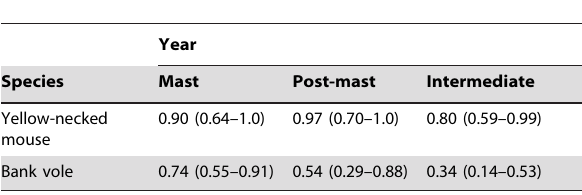
S3 Stable-carbon and